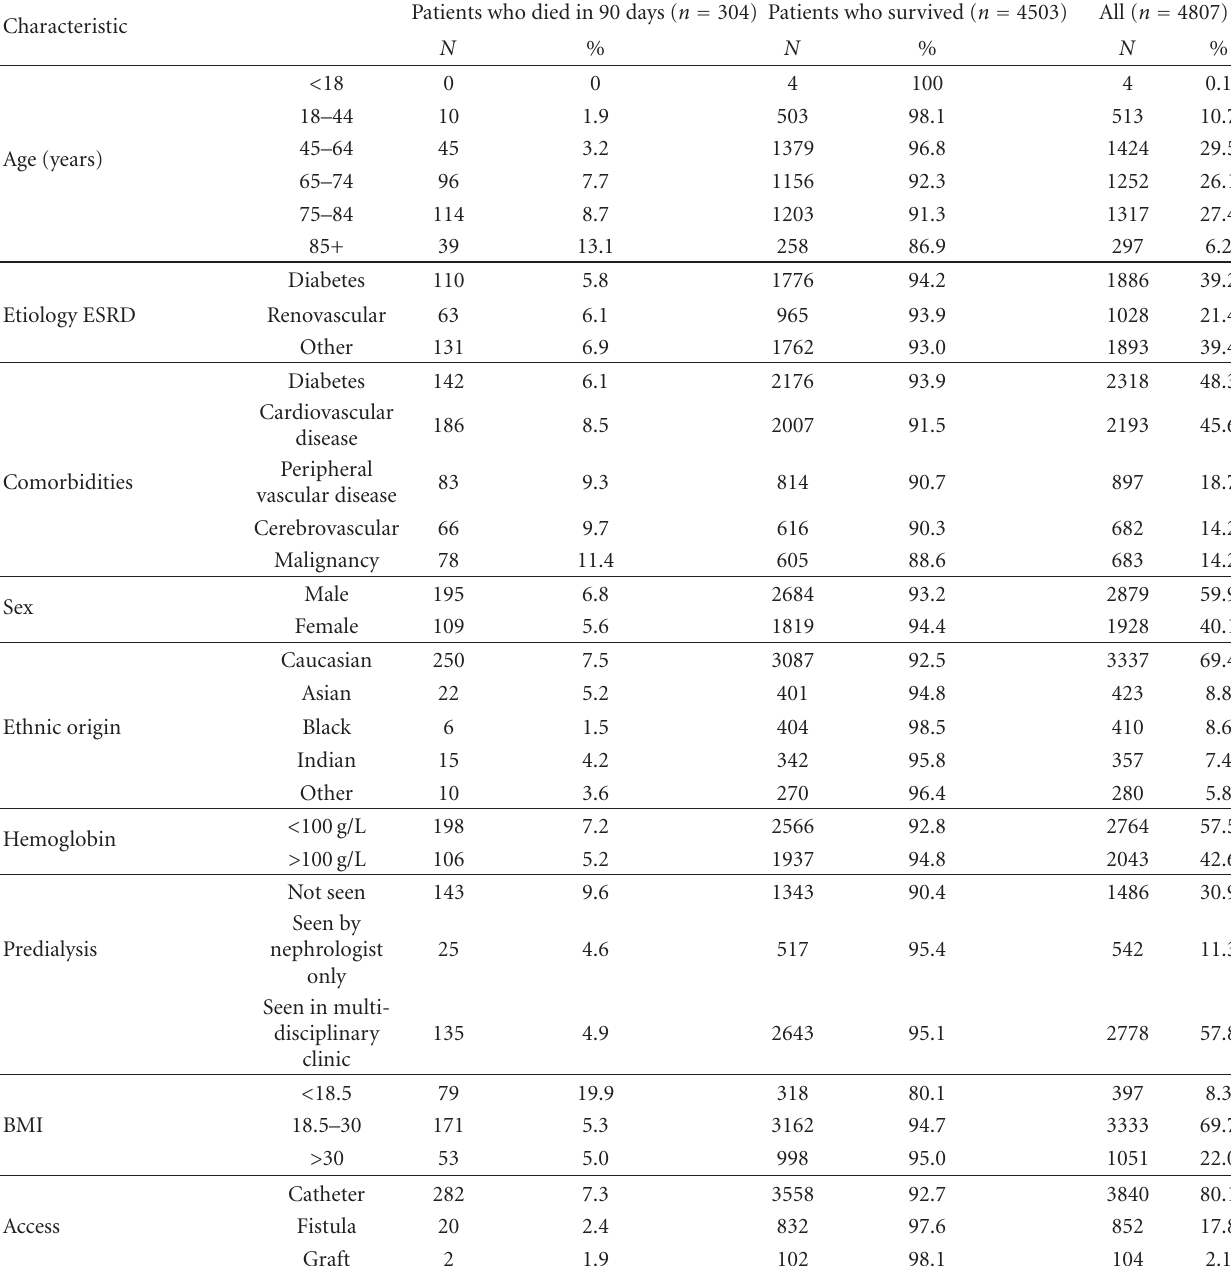
Table 1: Patient characteristics for TRDR cohort 2001 to